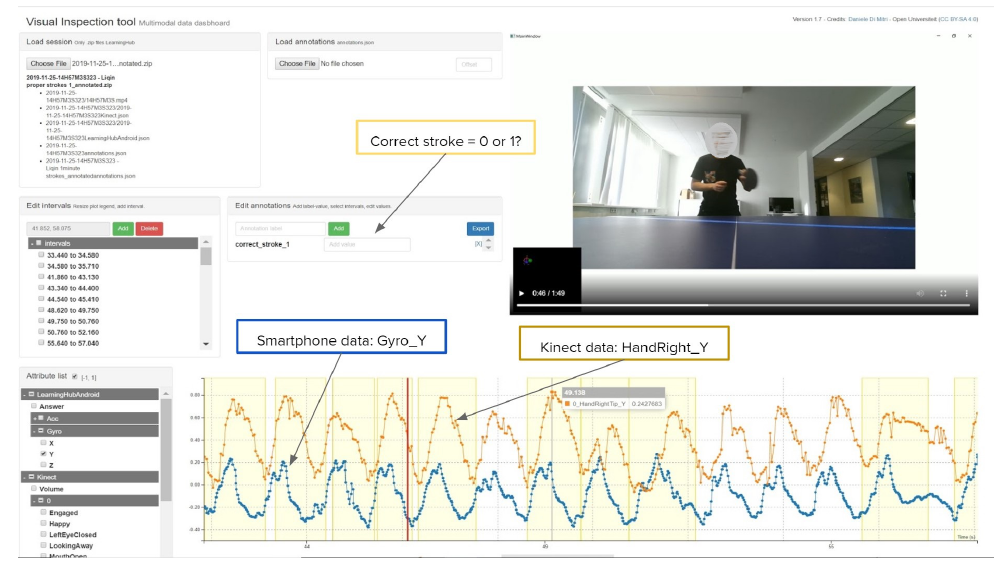
Figure 4. Screenshot of the VIT. Listing 3. Example of the annotation